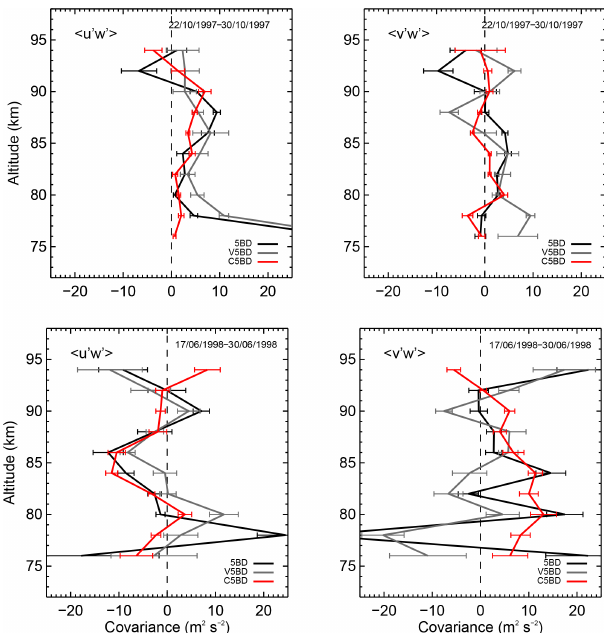
Figure 10. Vertical profiles of the momentum flux components obtained from the July 1997 (upper panels) and September 1997 (lower panels) campaigns. The error bars shown correspond to the standard error in the mean of the samples at each height.